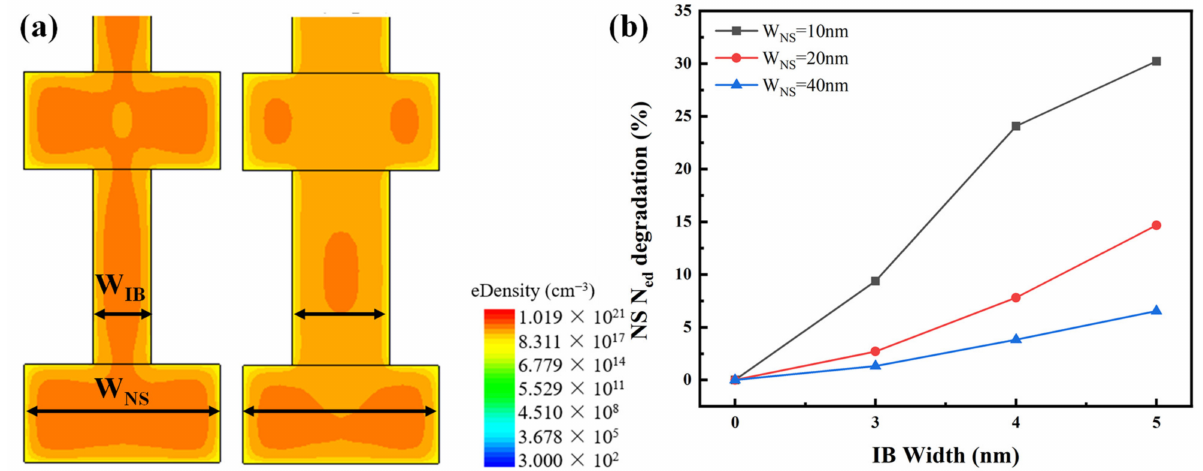
Figure 14. ( a ) Schematic diagram of the specific width W SW ; ( b ) NS total line electron density degradation, 0 represents a nanosheet without